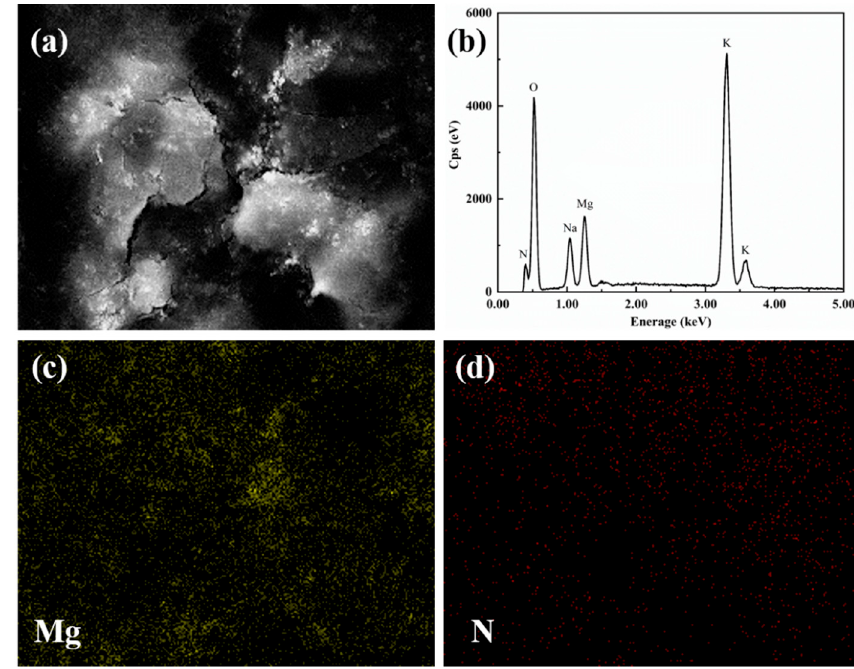
Figure 5. The elemental distribution of modified nitrate.